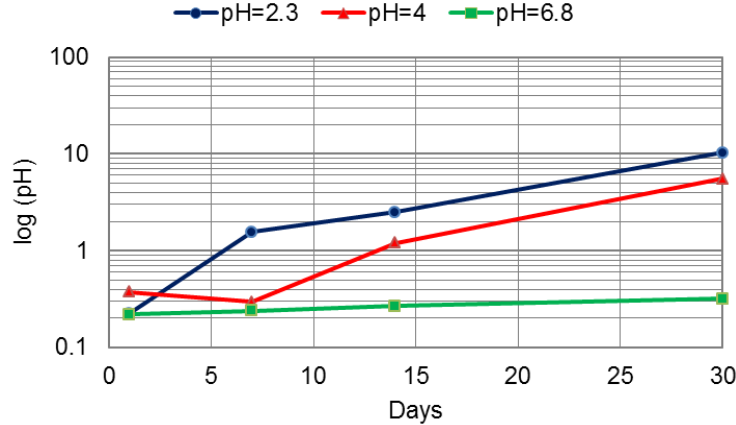
Figure 8. The difference between total release of Co, Cr and Mo from the CM and DMLS alloys (μg per cm 2 ) in artificial saliva of pH = 2.3, pH = 4 and pH =